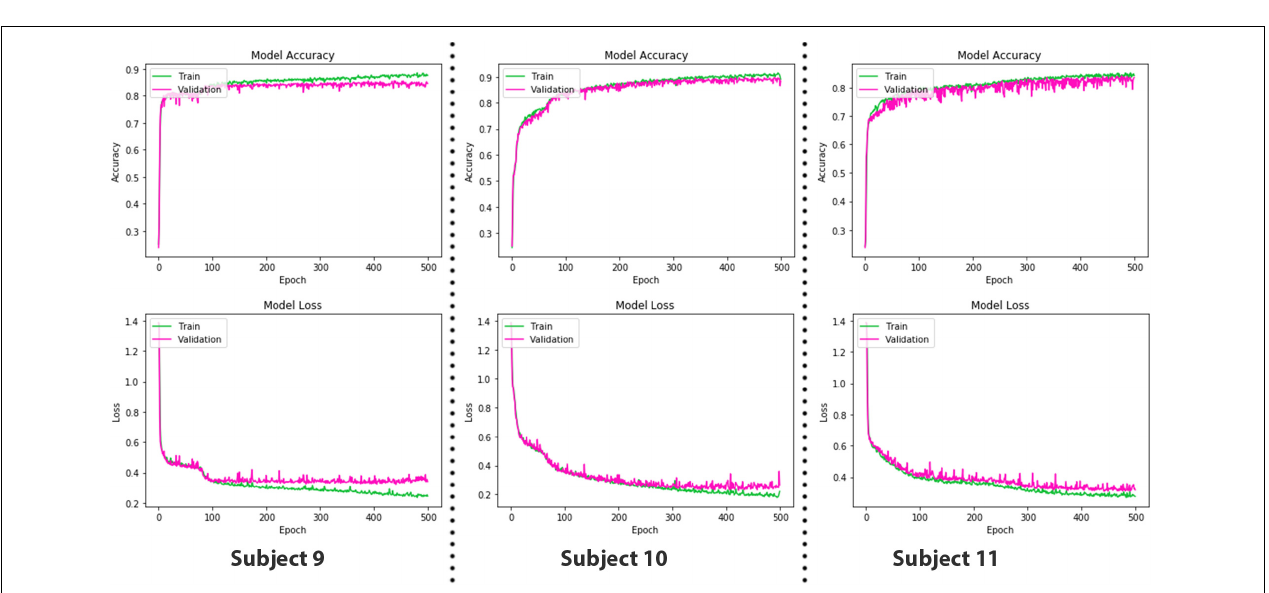
FIGURE 9 | (A) The repeating long short-term memory (LSTM) cell with input, forget, and output gates. (B) Complete model summary of the proposed LSTM network. (C) The architecture of the proposed LSTM network.